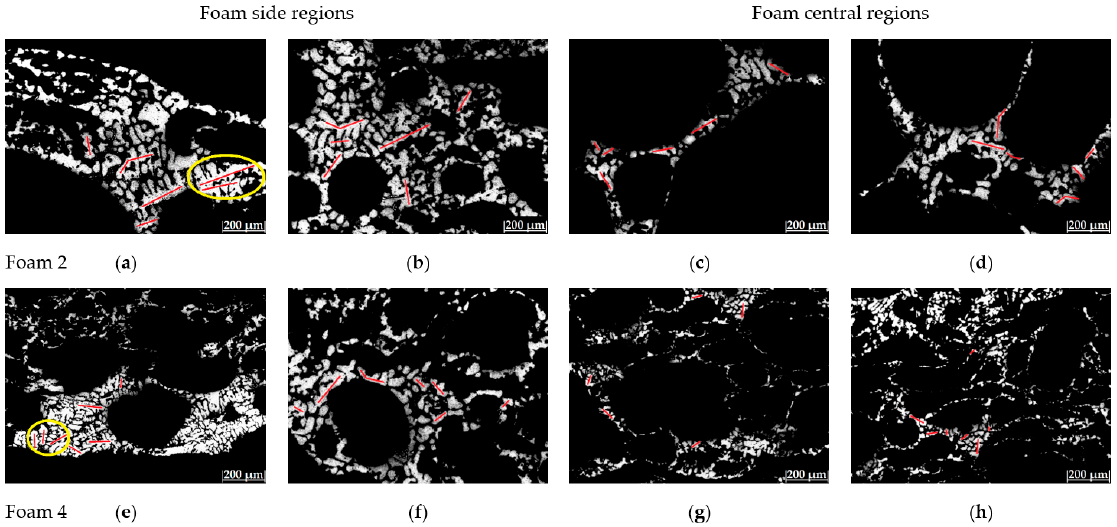
Figure 10. Optical microphotographs of A356 aluminum alloy foams 2 and 4 for regions located closer to the mold walls and in central regions of the foams. The micrographs were taken to ( a , e ) 50 × , ( b , f ) 100 × , ( c , g ) 200 × , and ( d , h ) 500 × . The circles show some dendrites while the red bar represent the dendrite length.